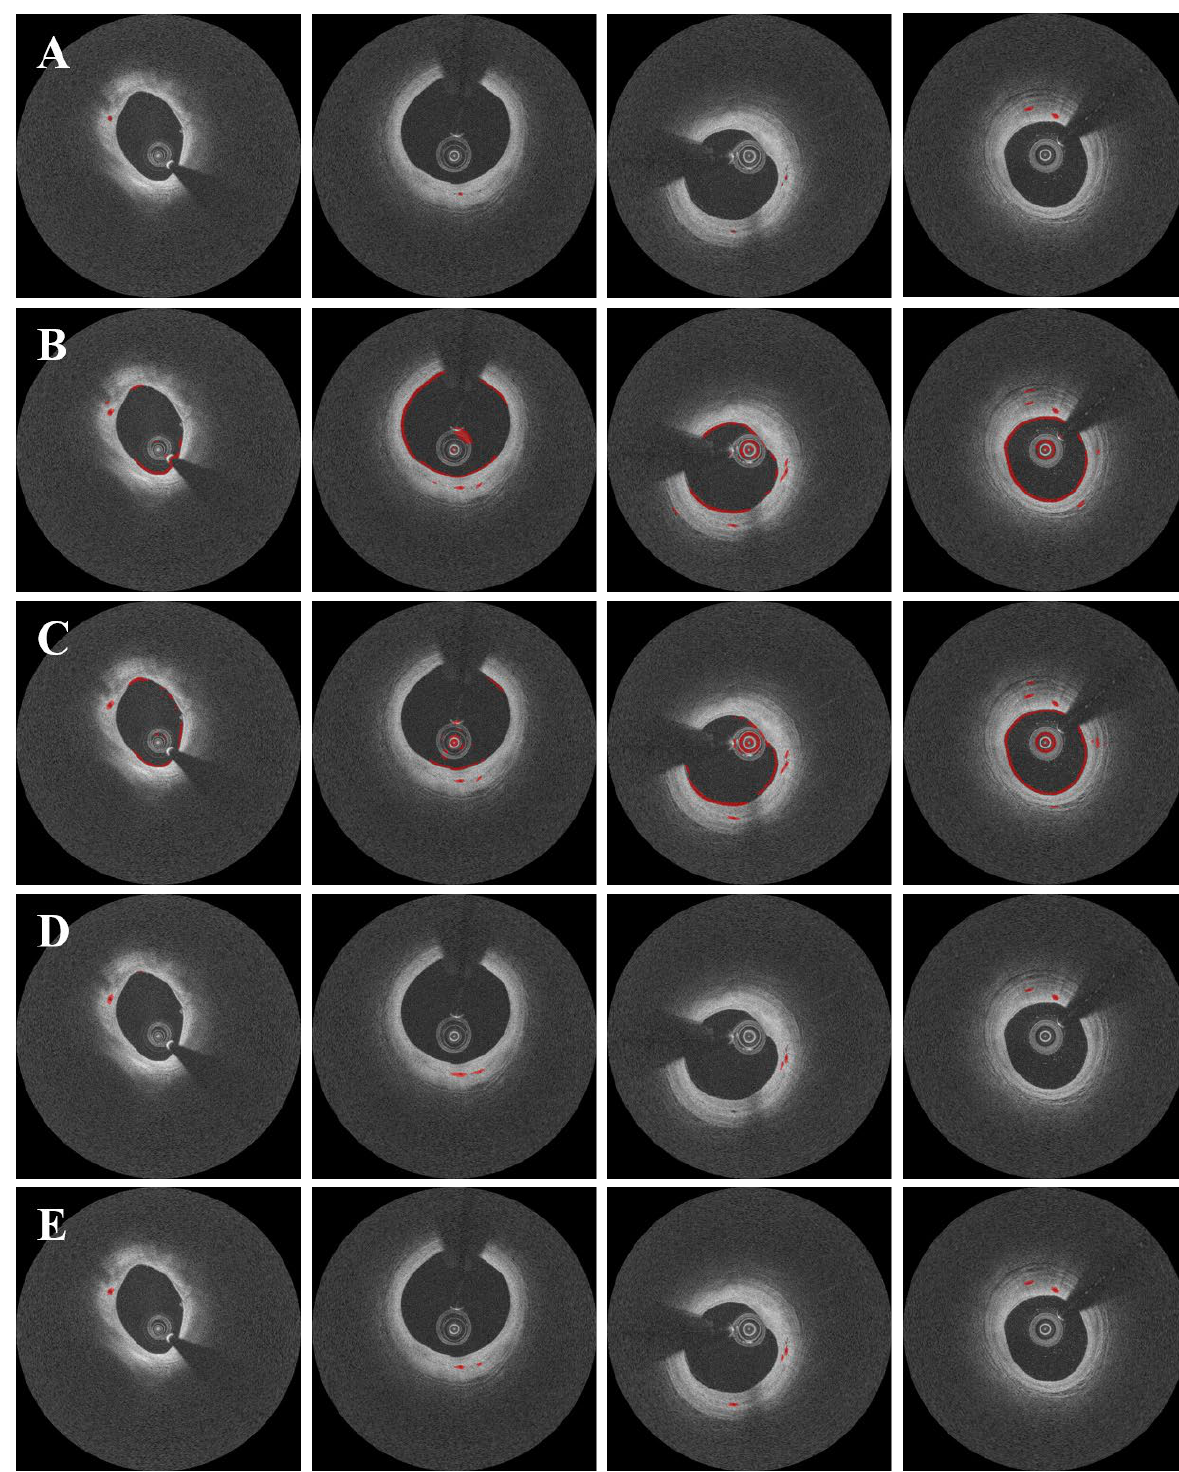
Figure 5. Segmentation results with and without data augmentation and pre-processing. Panels are results from ( A ) manual annotation, ( B ) raw polar IVOCT images, ( C ) data augmentation on the raw polar IVOCT image, ( D ) pre-processing alone, and ( E ) data augmentation and pre-processing. Both data augmentation and pre-processing improved the segmentation results. In some cases (second and third columns), our method detected microvessels that were missed during manual annotation, as confirmed by the analyst. Microvessels are labeled in